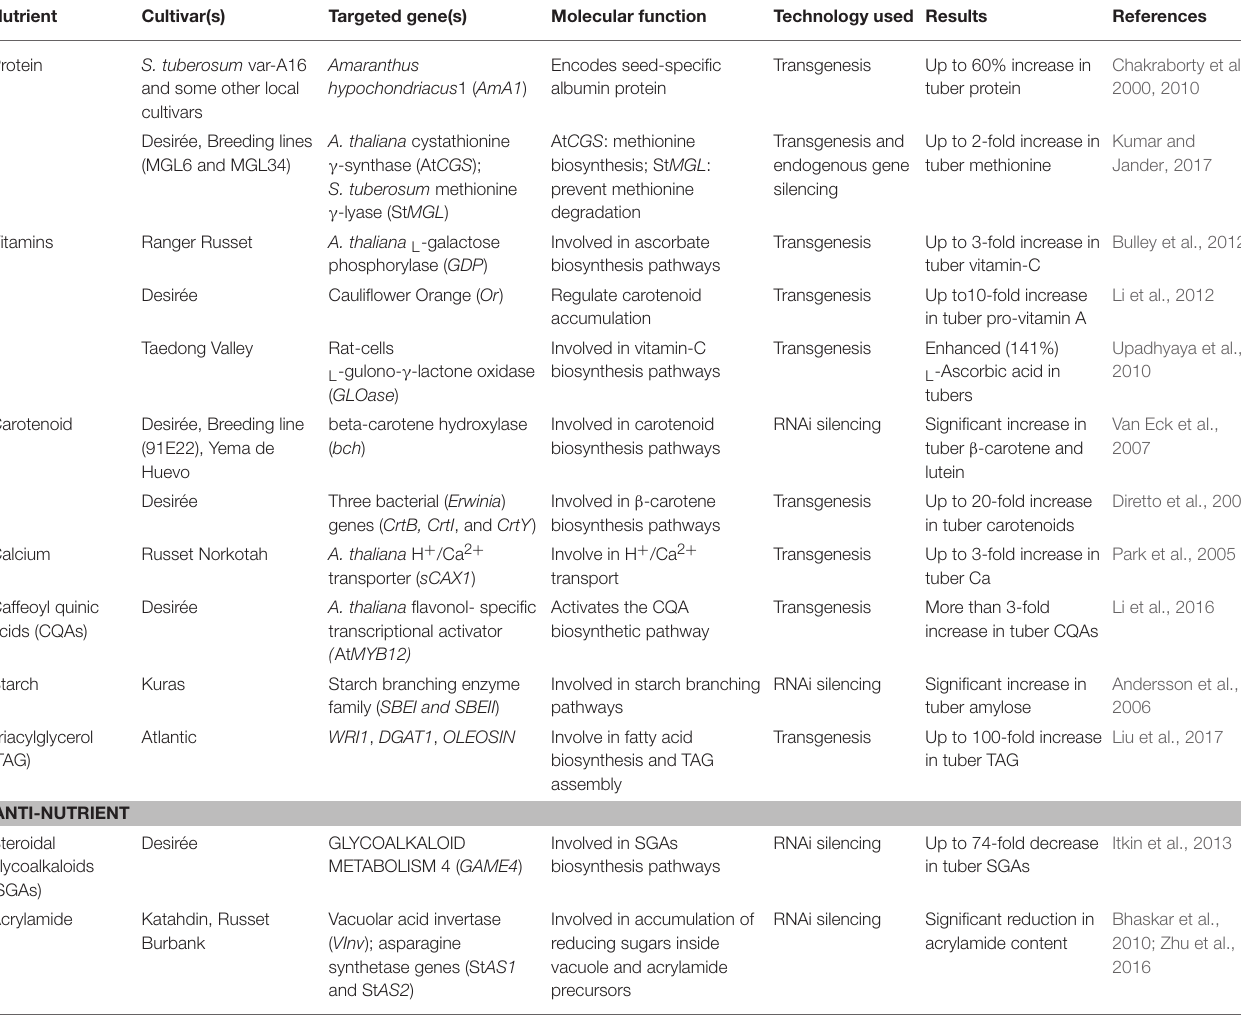
TABLE 1 | Transgenic potato enhanced for nutritional